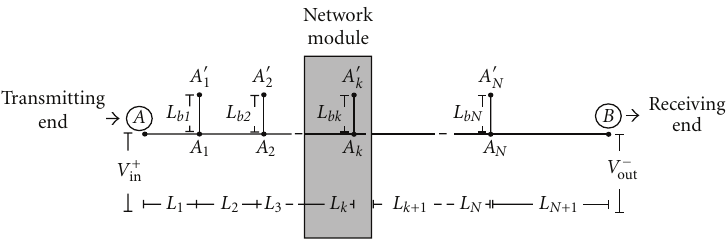
Figure 3: End-to-end HV/BPL connection with N branches and a network module [15, 26].